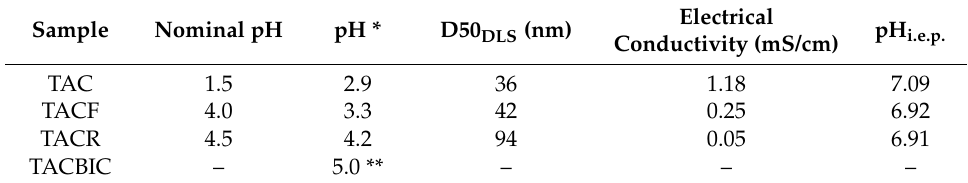
Table 1. Physicochemical characteristics of TiO 2 nanosol